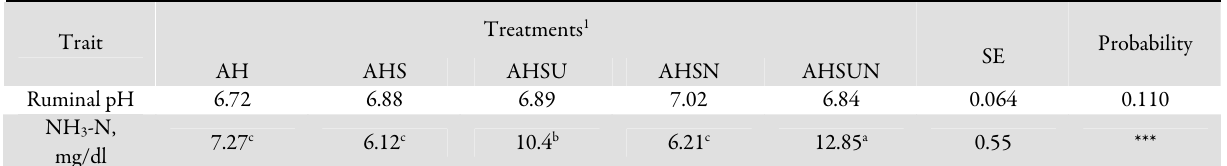
Tab. 3. Mean pH ruminal and ammonia-N concentration of experimental diets consisted of alfalfa hay plus sesame stover as untreated or treated with NaOH and/or urea in sheep